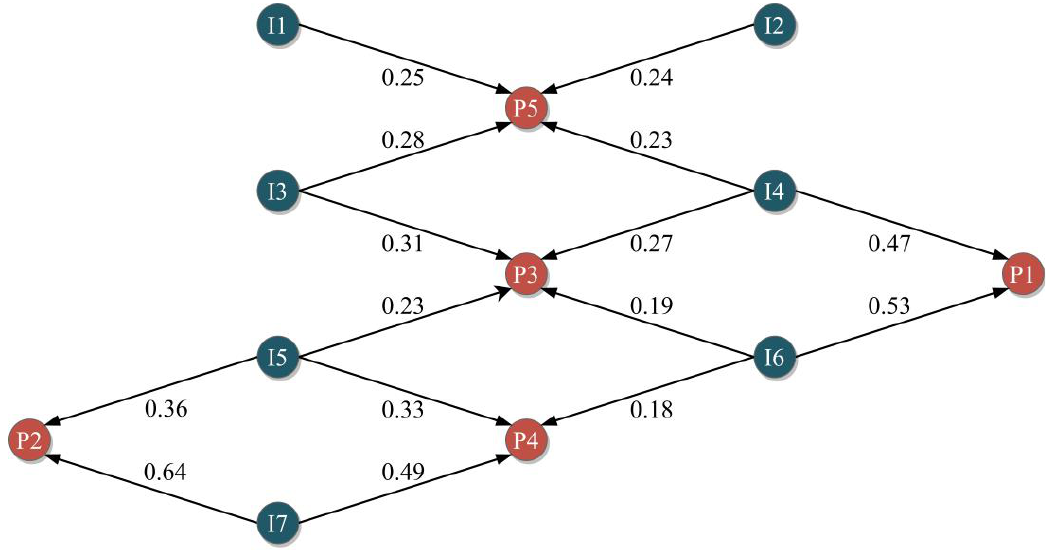
Figure 7. The producer – injector relationship coefficient of the target well pattern in this study.